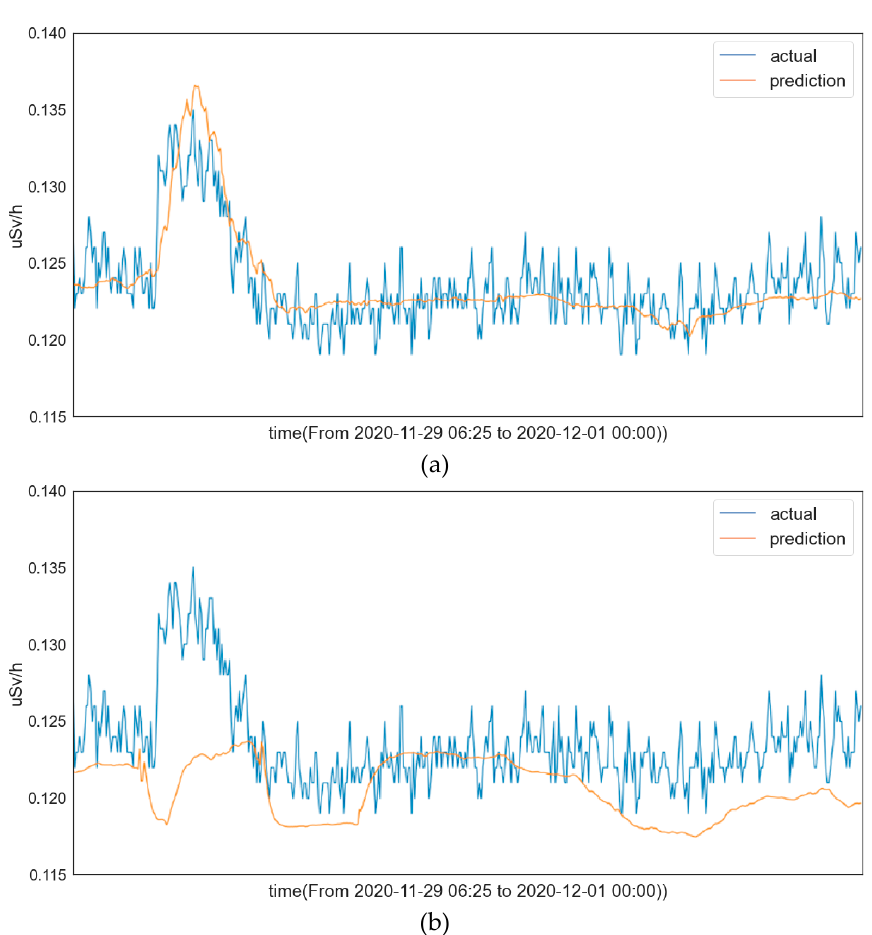
Figure 4. ( a ) Prediction curve of LSTM learning model with standardization preprocessing; ( b ) prediction curve of LSTM learning model with normalization preprocessing.